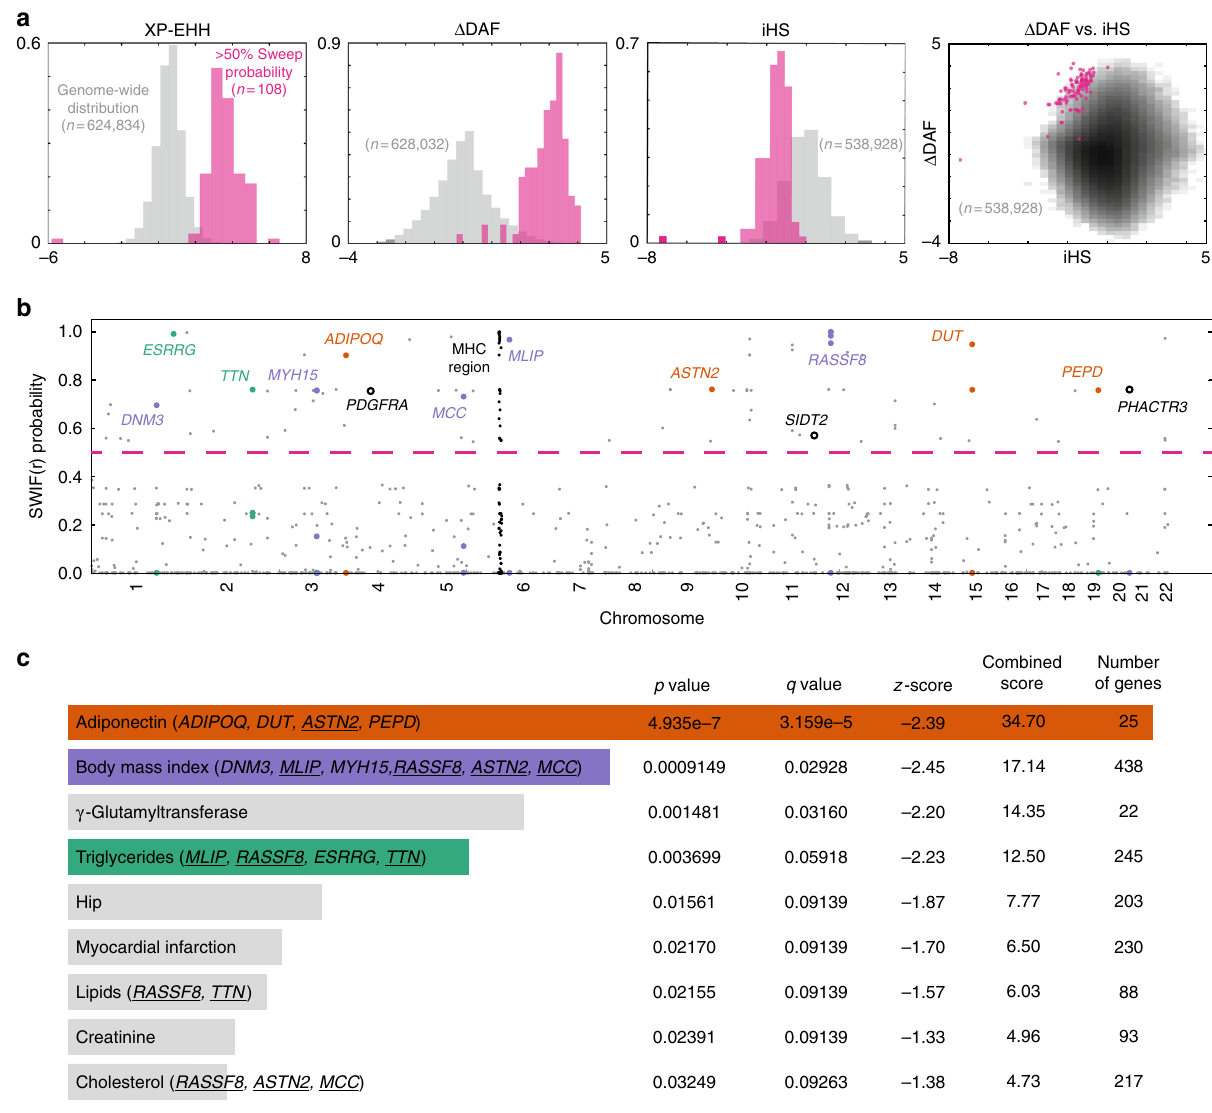
Fig. 3 Genome-wide SWIF(r) scan for adaptation in ‡ Khomani San SNP array data. a Empirical genome-wide univariate distributions of three of the component statistics, XP-EHH, Δ DAF, and iHS are shown in gray, as is the empirical joint distribution of Δ DAF and iHS (darker bins have more observations than lighter bins). The number of sites in each genome-wide univariate distribution differs due to some component statistics being unde fi ned more often than others. In pink are the corresponding distributions for the 108 variants that SWIF(r) identi fi es as having posterior sweep probabilities of > 50% (variants above the dashed pink line in b ). The full set of distributions can be found in Supplementary Fig. 25. b The value plotted for each position along the genome is the calibrated posterior probability of adaptation computed by SWIF(r) (per-site prior for a selective sweep is π = 10 − 4 to detect signals of relatively old sweeps given the high long-term N e of the ‡ Khomani San); only SNPs with a calibrated posterior sweep probability > 1% are plotted and the horizontal line indicates a probability cutoff of 50%. A strong signal of adaptation over the major histocompatibility complex on chromosome 6 is shown in black. Gene names are listed for genes previously associated with metabolism-related and obesity-related traits (colors match categories in c ; open circles denote genes of interest that are not in any category in c ). c We used gene set enrichment analysis tool Enrichr 35 to identify categories that had an overrepresentation of genes containing SWIF(r) signals (Supplementary Data 3). We found multiple enriched dbGaP categories related to metabolism and obesity, including adiponectin (a protein hormone that in fl uences multiple metabolic processes, including glucose regulation and fatty acid oxidation), body mass index, and triglycerides. Genes in these categories containing SWIF(r) signals are listed next to category names. p values, q values, and the total number of genes are shown for each category, and categories are ranked by a combined score computed by Enrichr 35 . Adiponectin, body mass index, and γ -glutamyltransferase all have q values below